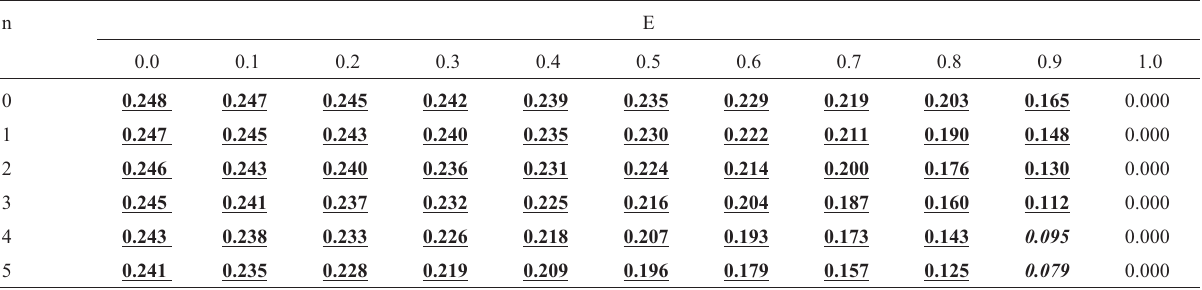
Table 3 - Recurrence risks for a sib of an isolated case, with consanguineous parents and F = 1/8 (half brothers, uncle-niece, double first cousins), in function of the rate of environmental cases (E) and of the number of normal sibs (n = n m + n f ) that the affected child already has. n E 0.0